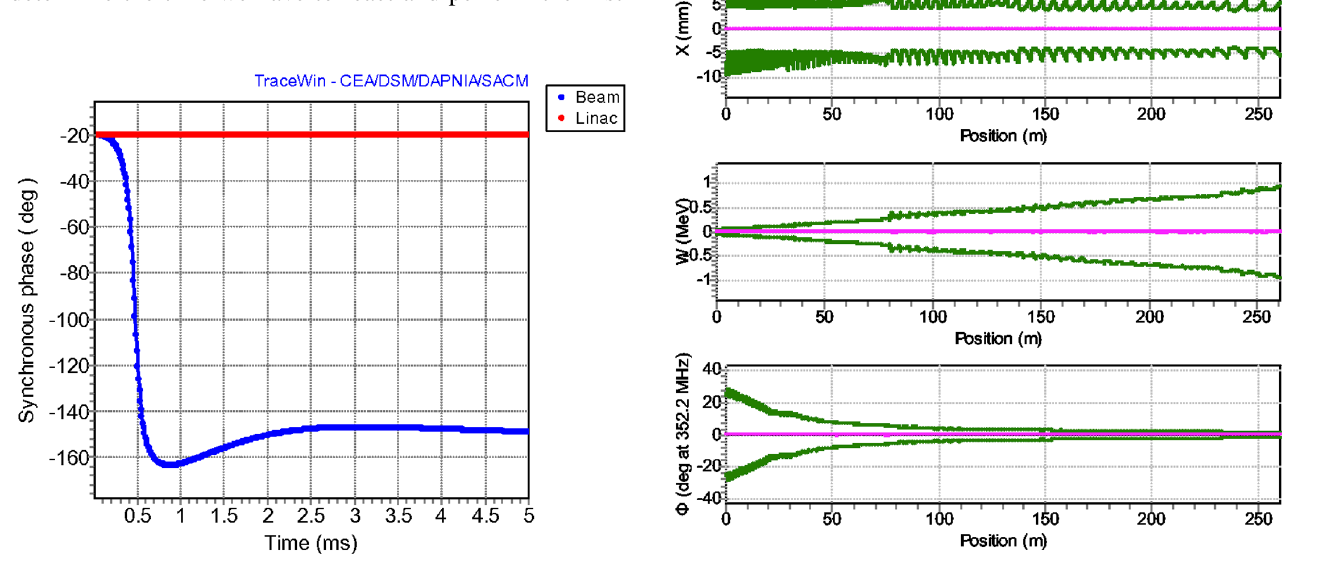
FIG. 6. (Color) Synchronous phase in the failed cavity. FIG. 8. Envelopes at 0 (cid:4) s , reference